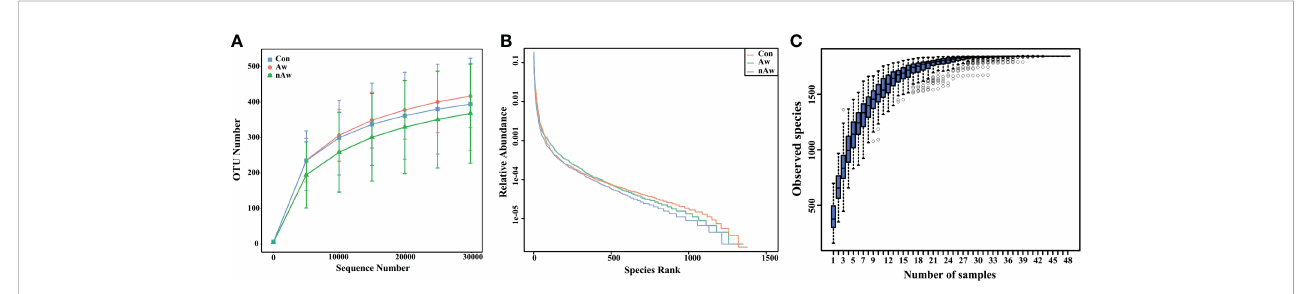
FIGURE 1 Estimation of sample depth in the Aw, nAw, and Con groups. (A) Rarefaction curves. (B) Rank Abundance curves. (C) Species Accumulation Boxplots. Aw, atopic wheezing group; nAw, non-atopic wheezing group; Con, foreign body aspiration infants as